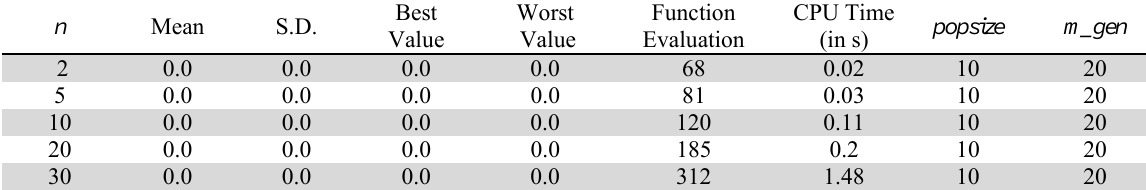
Computational Results of Problem -10